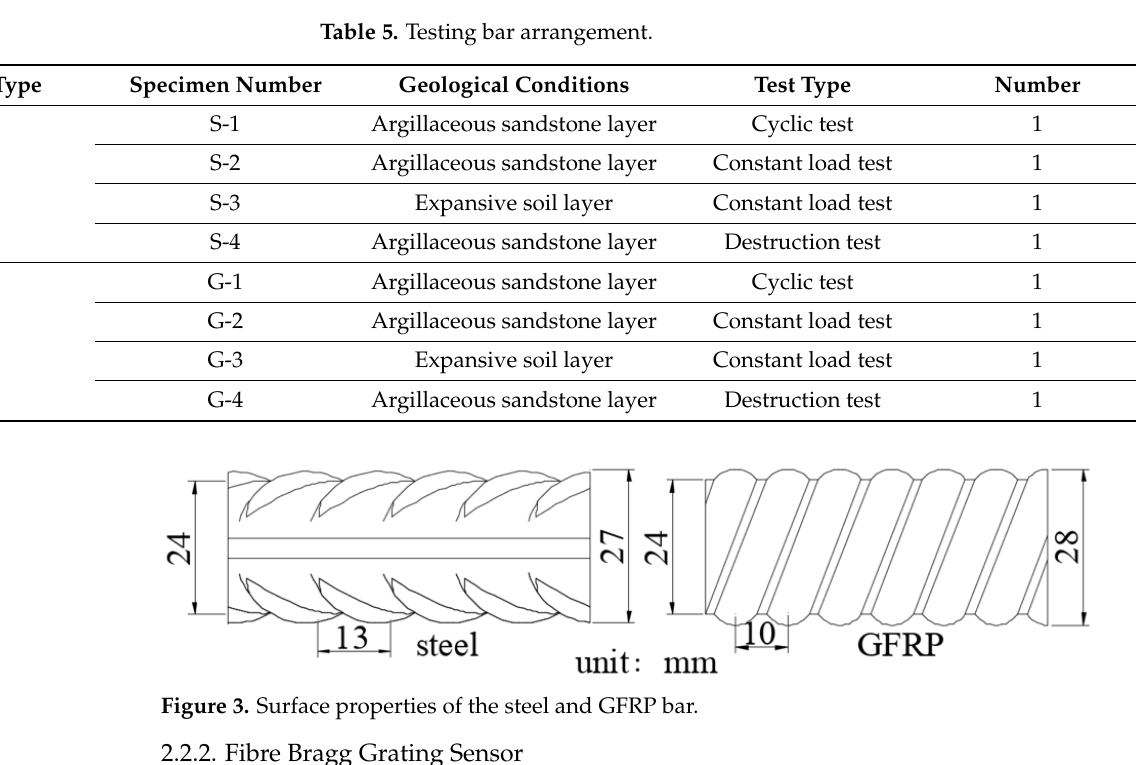
Table 4. Mechanical properties of the GFRP bar.